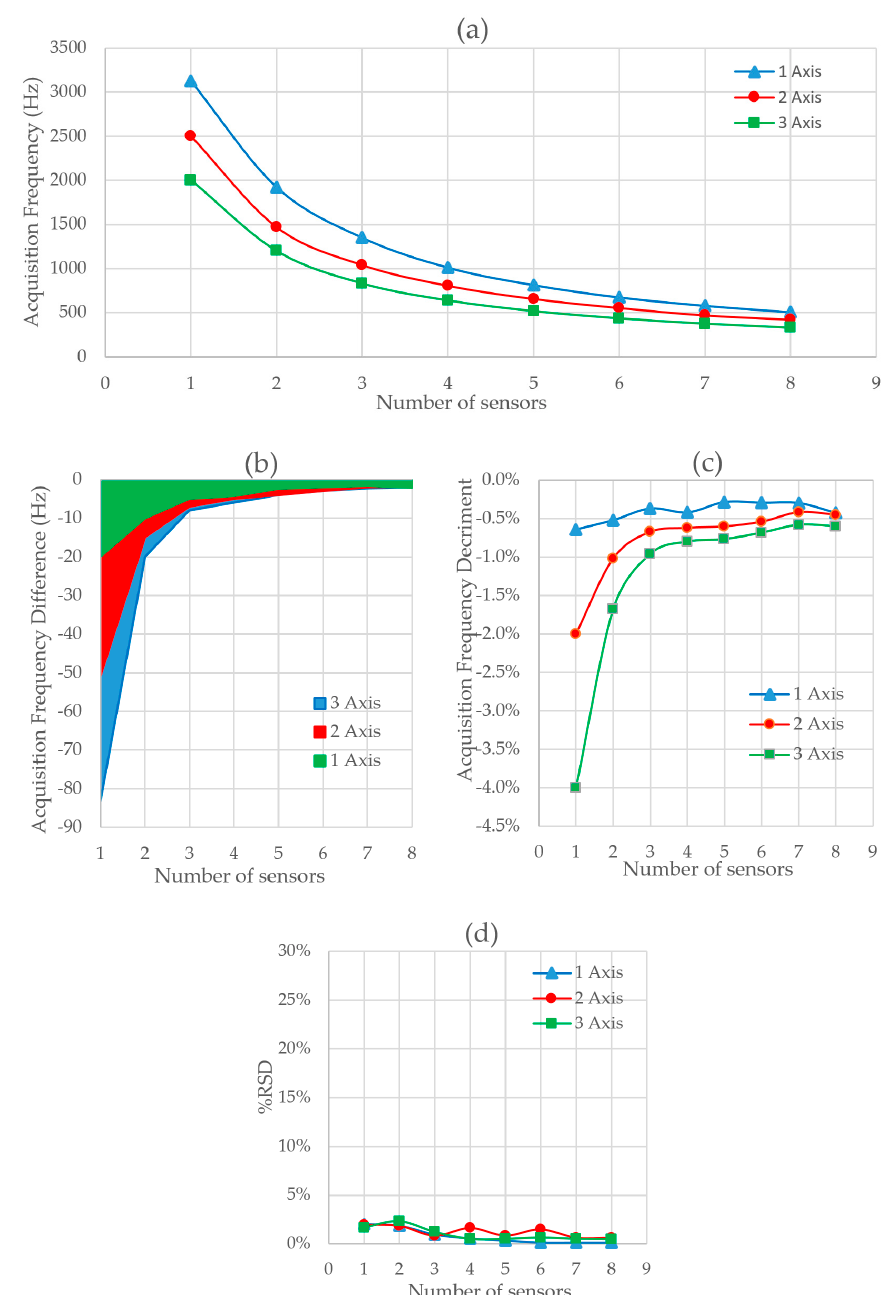
Figure 11. ( a ) Acquisition frequency depending on the number of sensors and axis read at the same time with stuffing method and 3 bytes of time, ( b ) total variation of the data acquisition frequency between Test 4 and Test 5, ( c ) percentage increase of the data acquisition frequency between Test 4 and Test 5, and ( d ) acquisition frequency RSD depending on the number of sensors and axis read with stuffing method and 1 byte of time